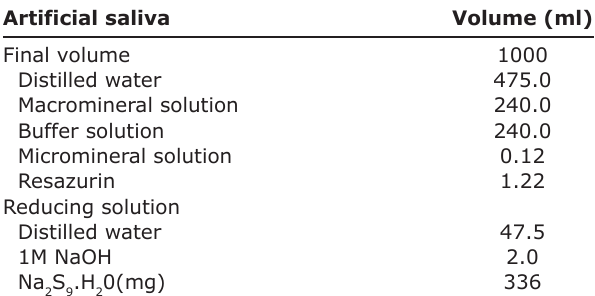
Table-2: Composition of in vitro solution Artificial